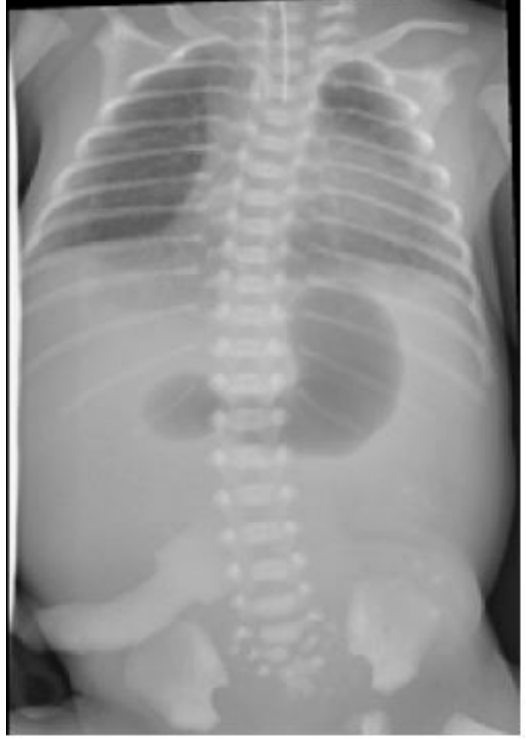
Figure 2. Radiograph demonstrating characteristic double-bubble appearance.